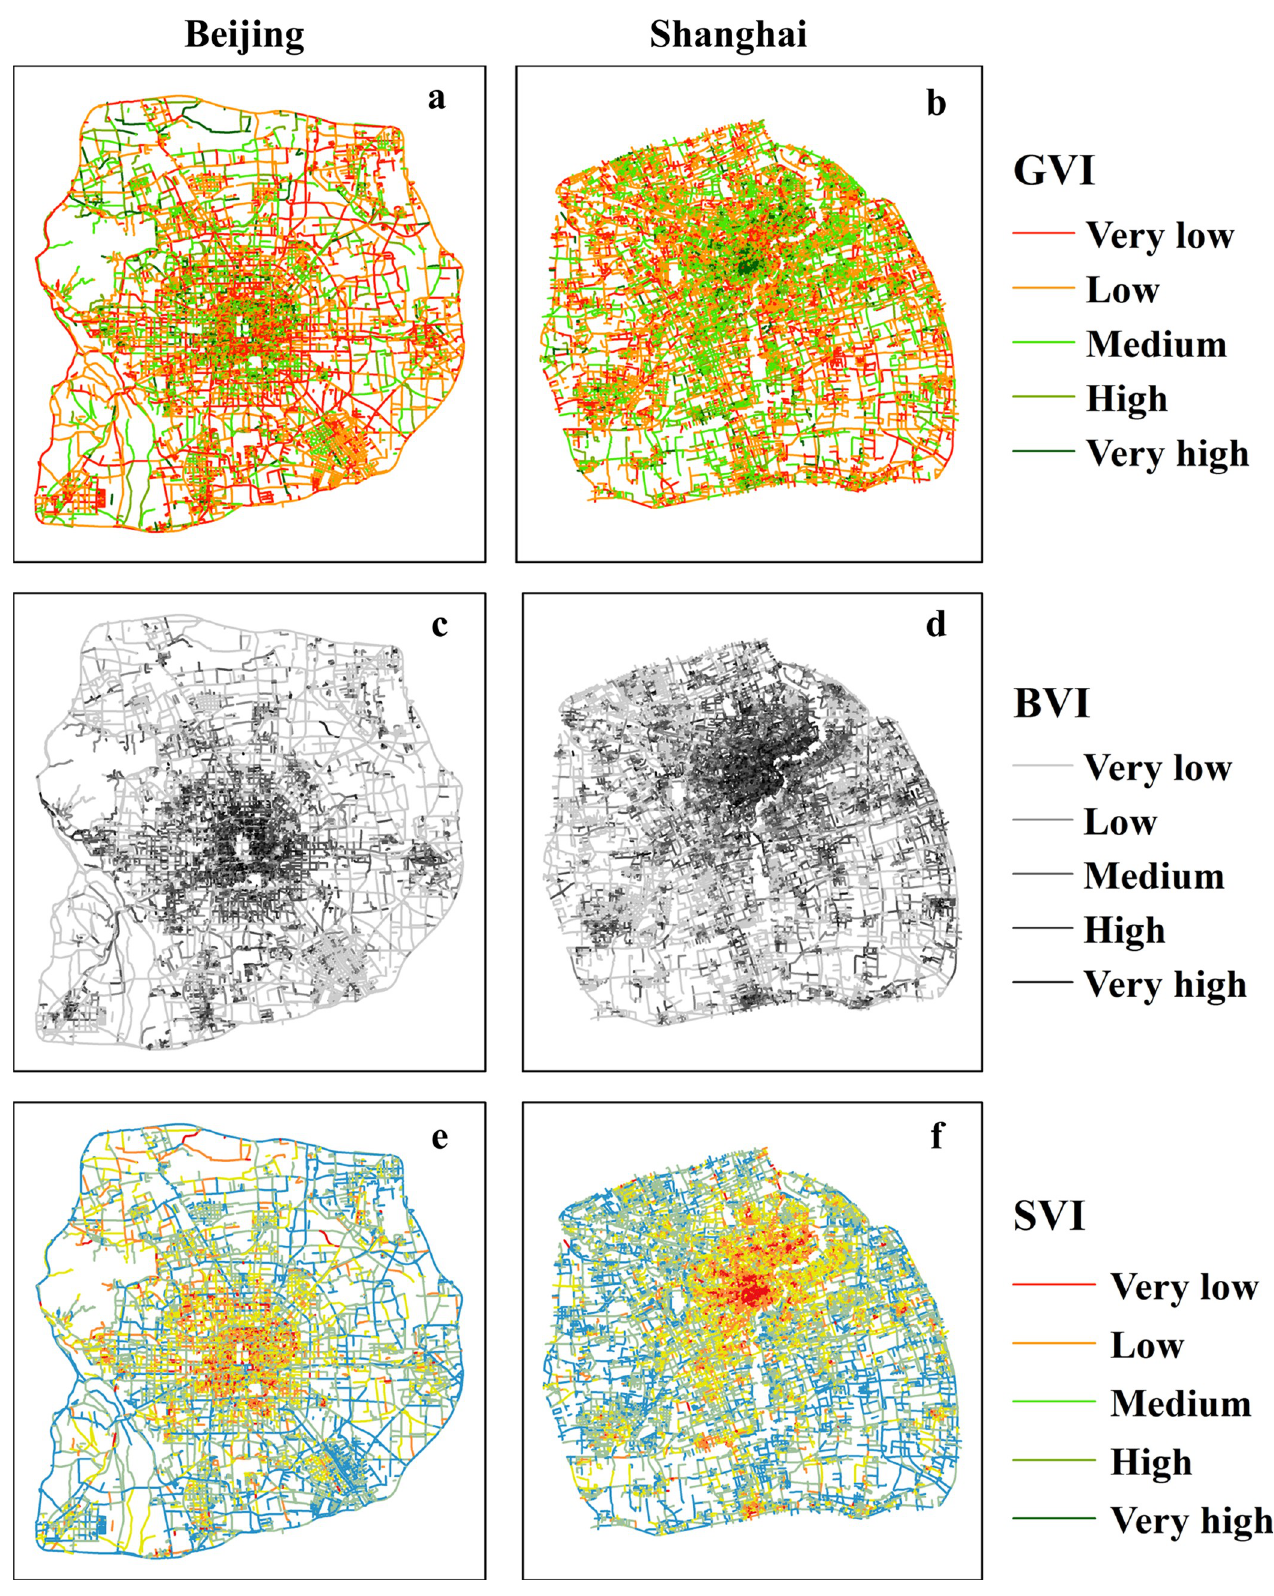
Fig 5. The spatial distributions of VIs in Beijing and Shanghai (GVI, BVI and SVI). https://doi.org/10.1371/journal.pone.0217505.g005 PLOS ONE | https://doi.org/10.1371/journal.pone.0217505 May 30,